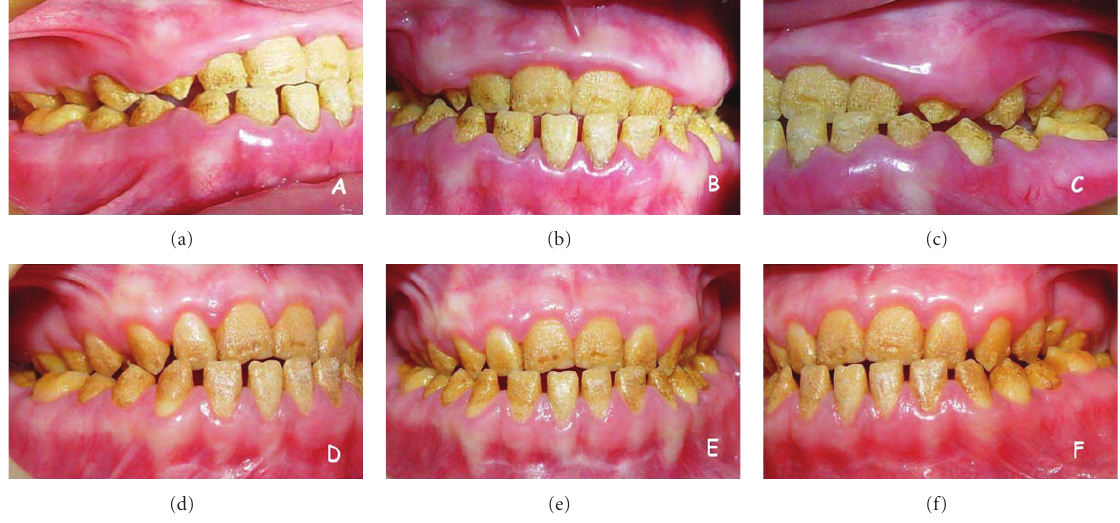
Figure 1: Initial aspect of the 12-year-old patient displays di ff use gingival enlargements covering almost all teeth ((a), (b), and (c)). Appropriate gingival form is established by periodontal flap surgery and maintained for 3 years ((d), (e), and (f)).